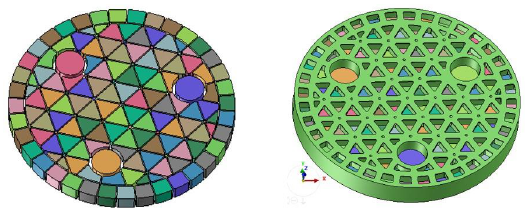
Figure 3. The filler and initial slurry model.